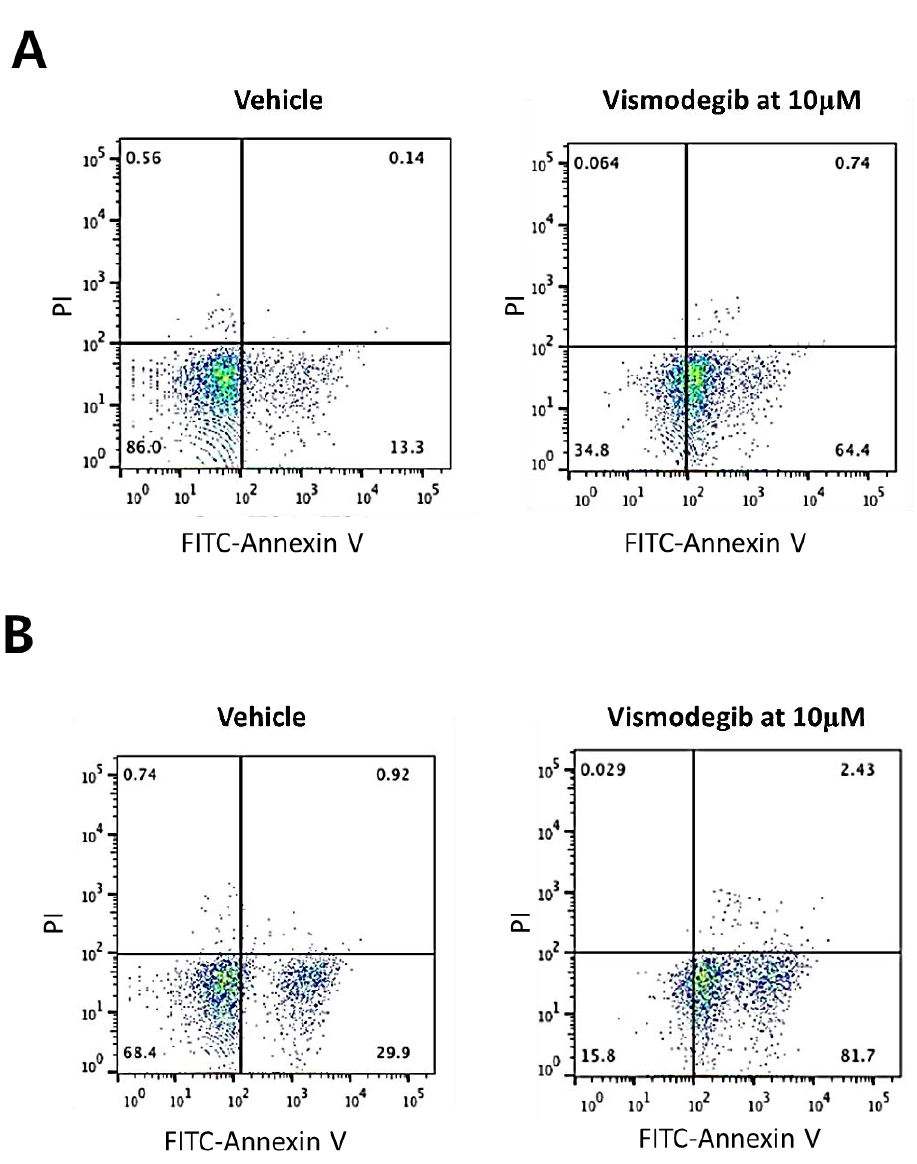
Figure 3. Treatment with vismodegib at 10 µ M induced apoptosis in CCC cells. The y-axis represents PI staining and x-axis represents Annexin V staining. ( A ) SNU-1079; ( B ) SNU-245.